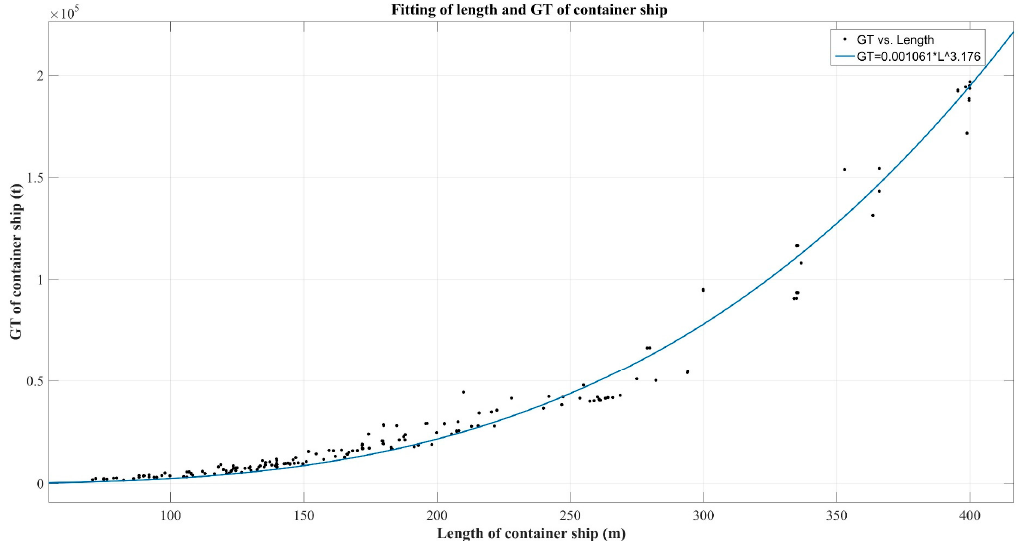
Figure 3. The relationship between the length and GT of container ship.